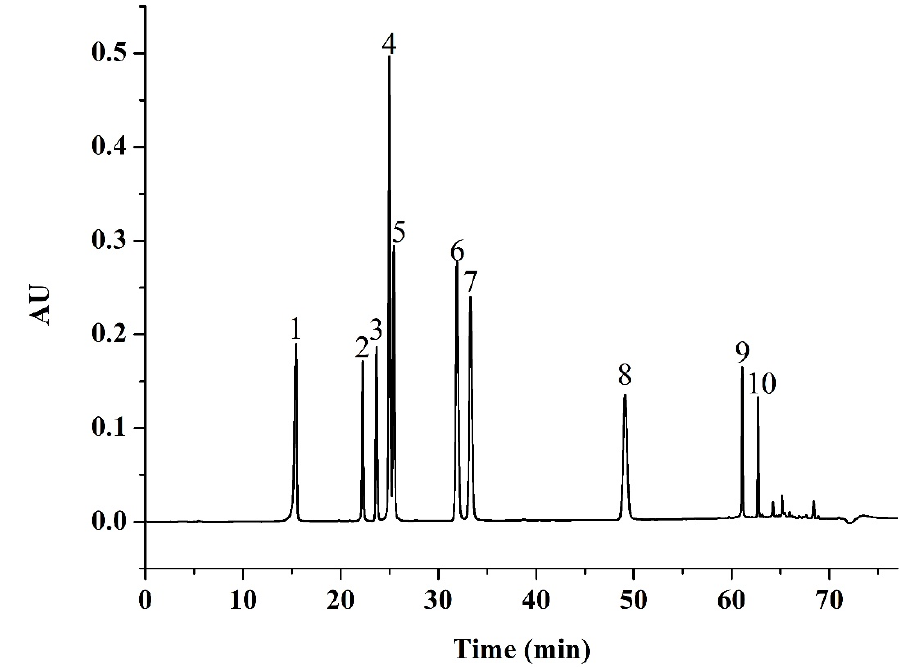
Figure 6. HPLC chromatogram of mixed standards. Peak 1, gallic acid; 2, chlorogenic acid; 3, p -hydroxybenzoic acid; 4, vanillic acid and caffeic acid; 5, syringic acid; 6, p -coumaric acid; 7, ferulic acid; 8, o -coumaric acid; 9, luteolin; 10, apigenin. Table 7. Contents of identified phenolic compounds in extracts from Jizi439 BWB ( µ g / mg dry